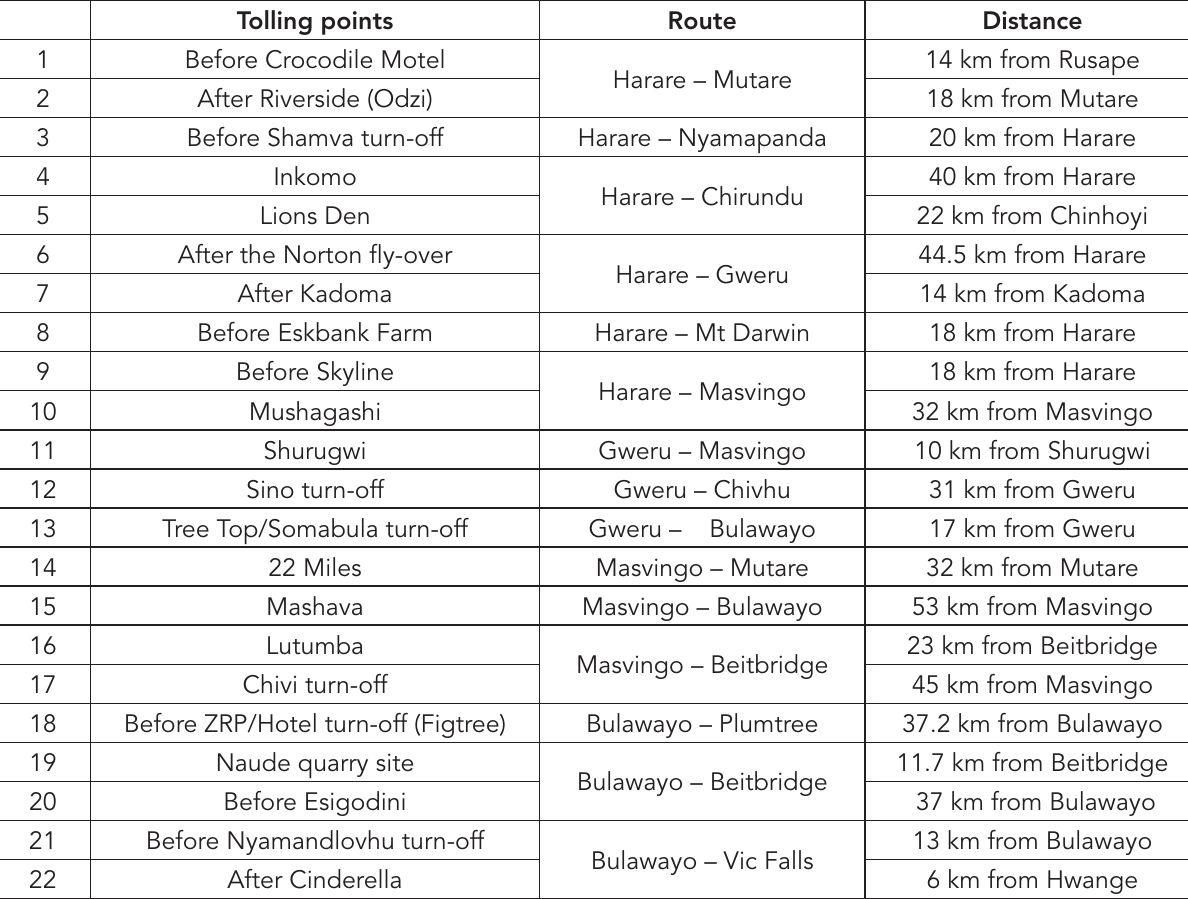
Table II: Summary of location of toll collection